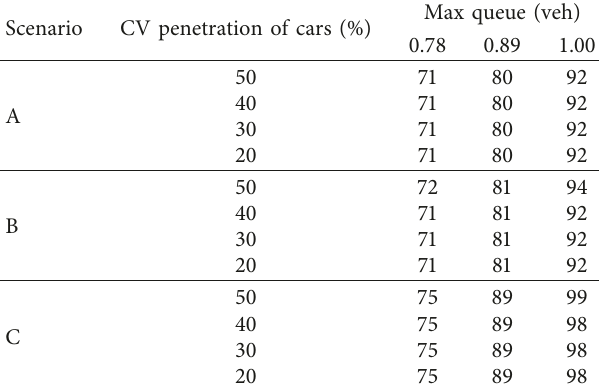
Table 5: Results of the max